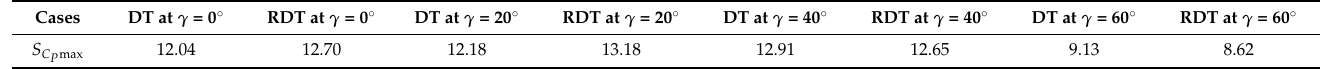
Table 2. S C corresponding to DT and P max